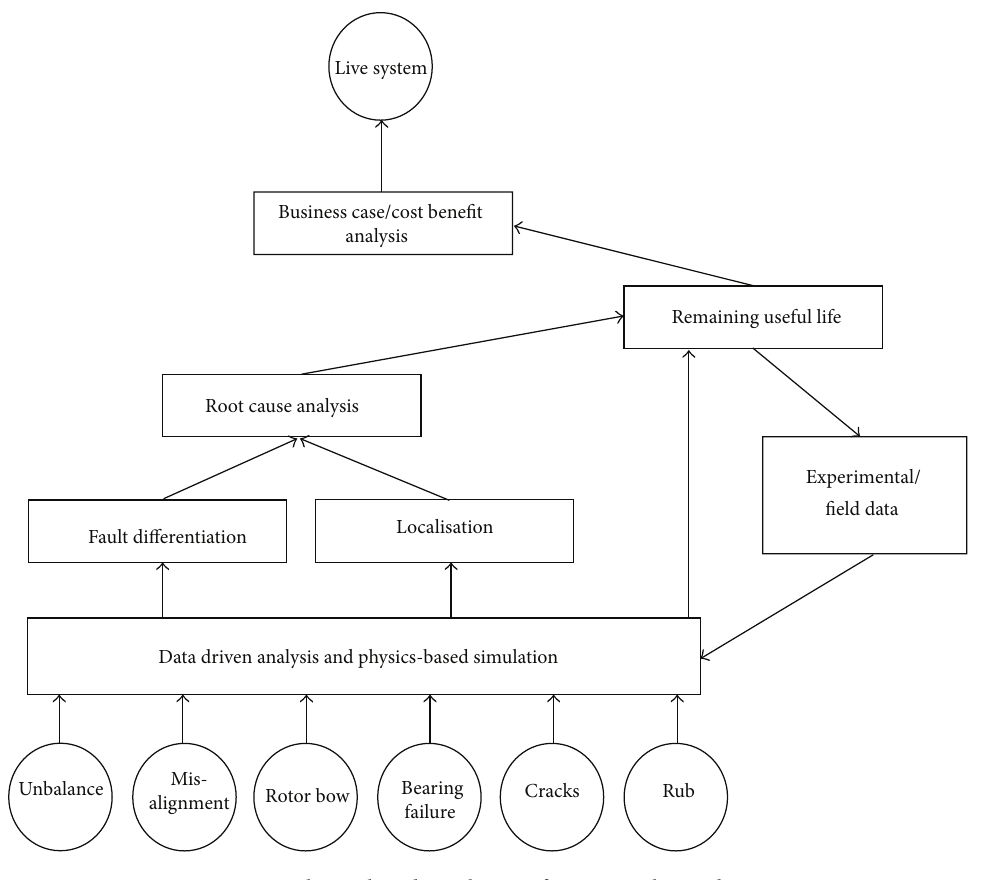
Figure 1: Physics-based simulation—from research to